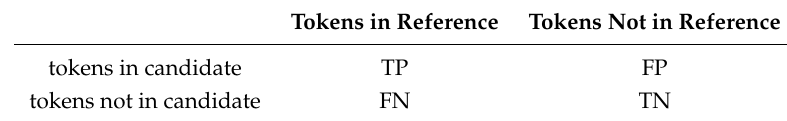
Table 8. The definition of true positive (TP), true negative (TN), false positive (FP), false negative